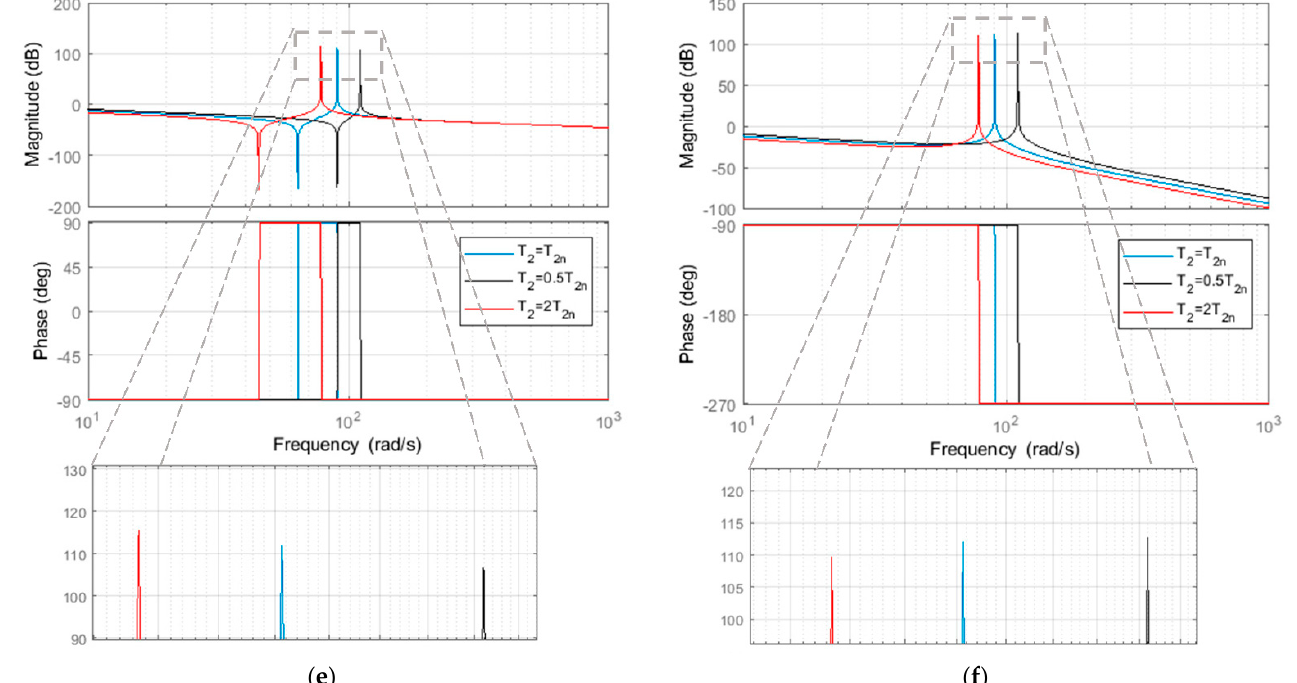
Figure 3. The frequency characteristics of the oscillating system: ( a ) response of the system described with equation (26) to the changes in T c ; ( b ) response of the system described with equation (27) to the changes in T c ; ( c ) response of the system described with equation (26) to the changes in T 1 ; ( d ) response of the system described with equation (27) to the changes in T 1 ; ( e ) response of the system described with equation (26) to the changes in T 2 ; ( f ) response of the system described with equation (27) to the changes in T 2 .